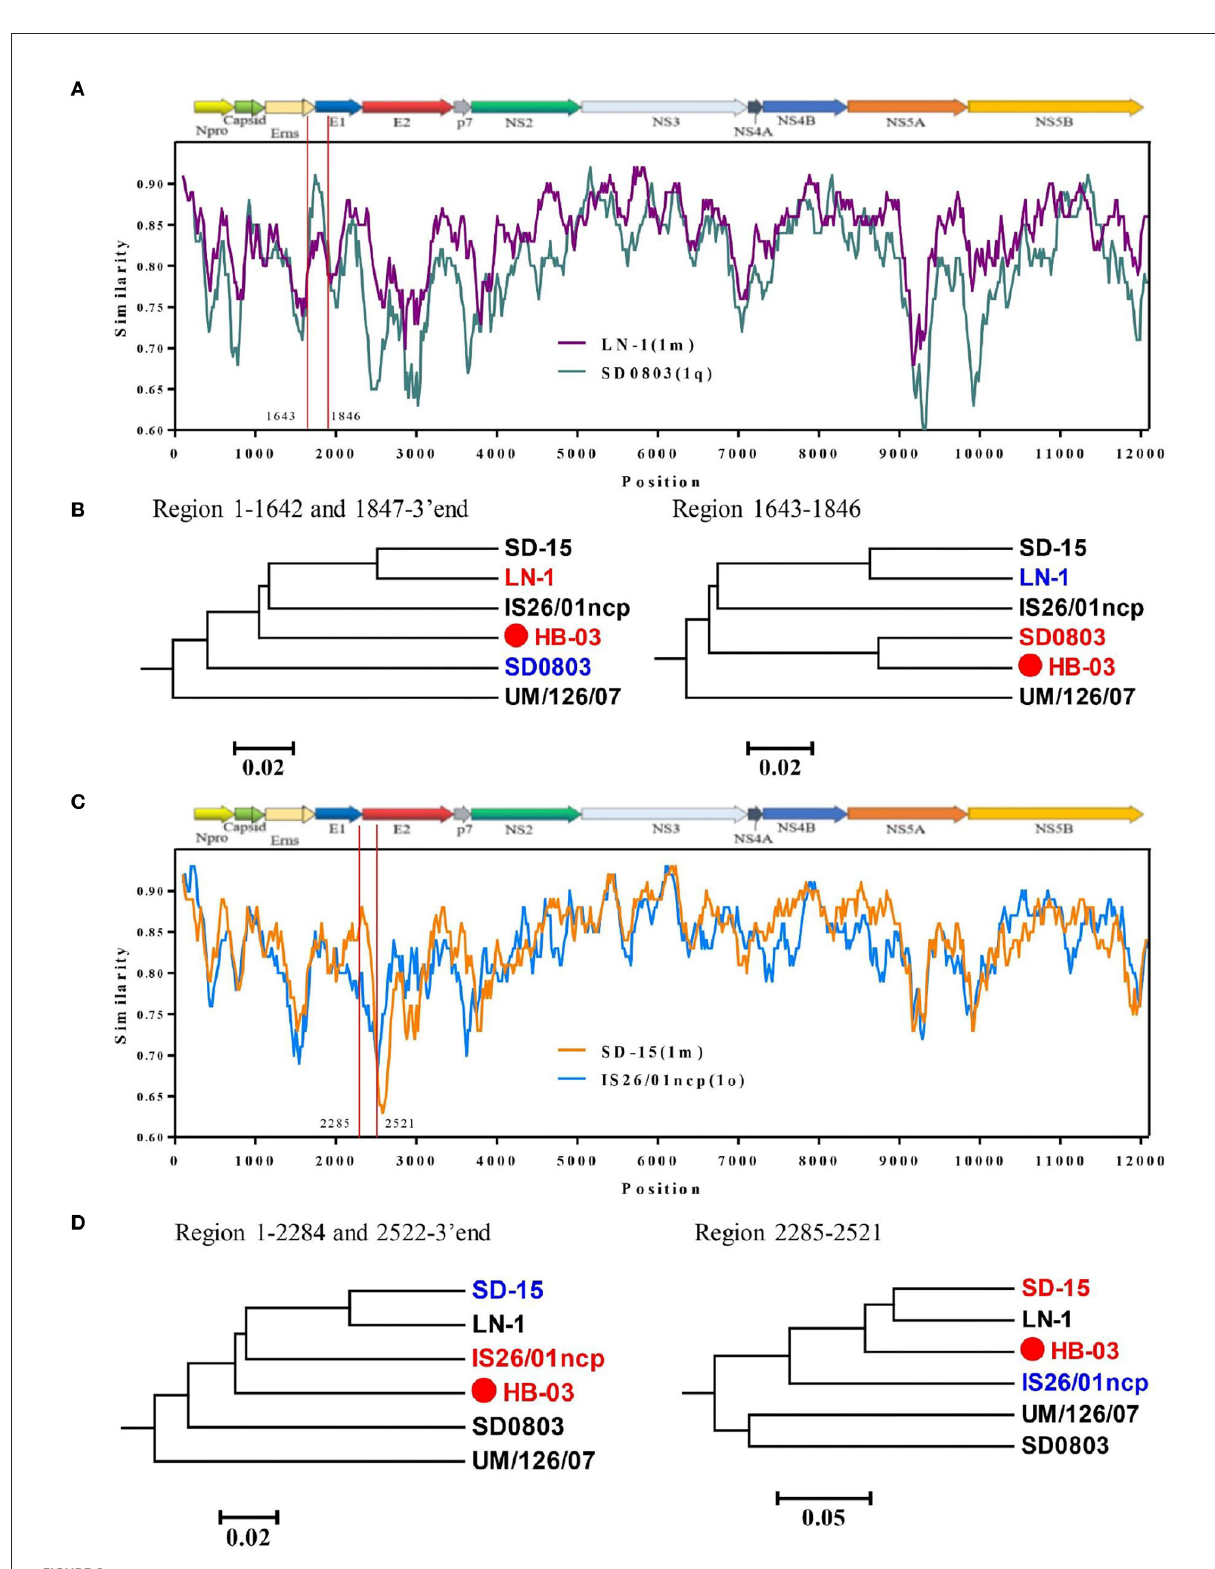
FIGURE6 Recombination analysis of the BVDV-1v HB-03 strain genome. Similarity plots and boot scanning analyses were performed using the SimPlot (Similarity Plotting) software package (version 3.5.1). Recombination breakpoints are shown with red lines, and the locations are shown at the side. (A,C) Show that there were two potential recombination events in BVDV-1v HB-03, respectively. Phylogenies of the major and minor parent regions are shown below the similarity plot (B,D)